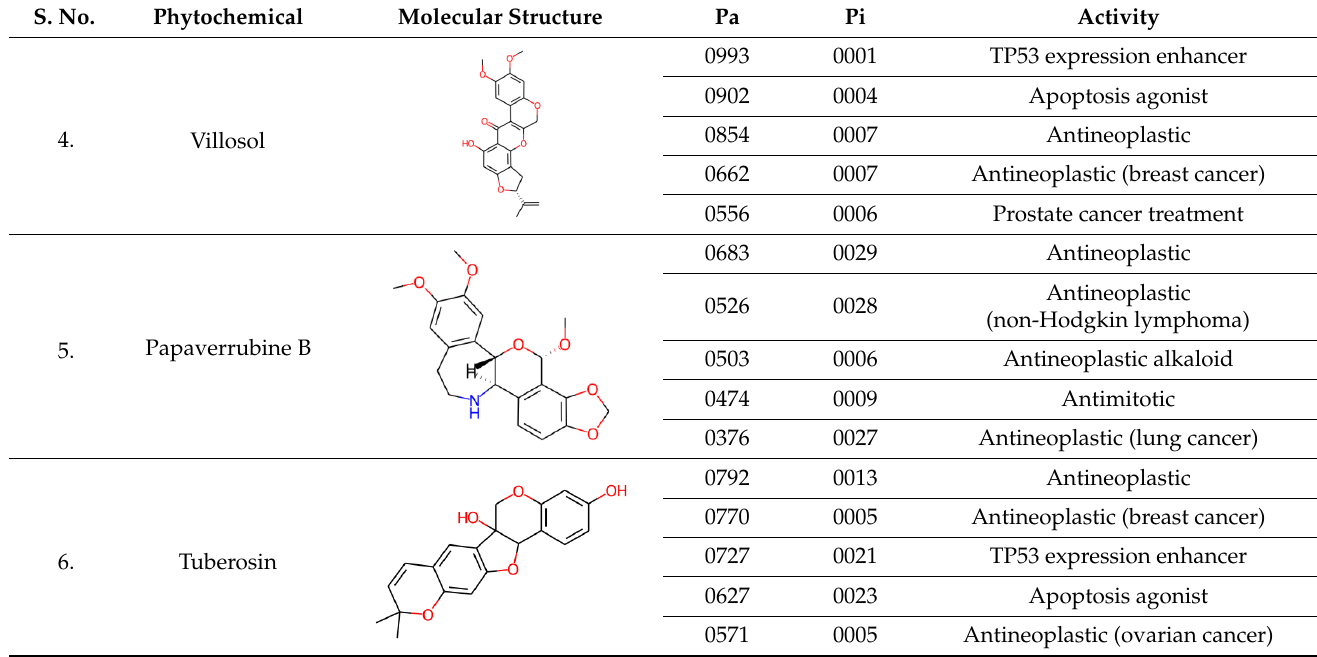
target protein. The elaborate studies in the interaction unveil different types of noncovalent interactions that are formed between AKT1 and tuberosin or villosol. The two-dimensional plots of the probable interactions were obtained for both the compounds using Discovery Studio Visualizer. Both compounds interact with the Lys179 and Asp 274 residues on the ATP binding site and active site, respectively (Figure 2). Both compounds share common features of binding and, thus, can act as ATP-competitive inhibitors of AKT1. The selected conformations of both compounds were taken for all-atom MD simulations for 100